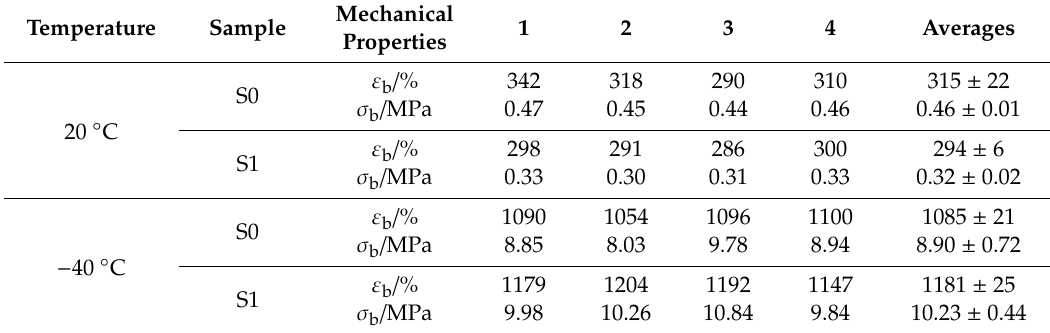
Table 2. Mechanical properties of elastomers at different temperatures.